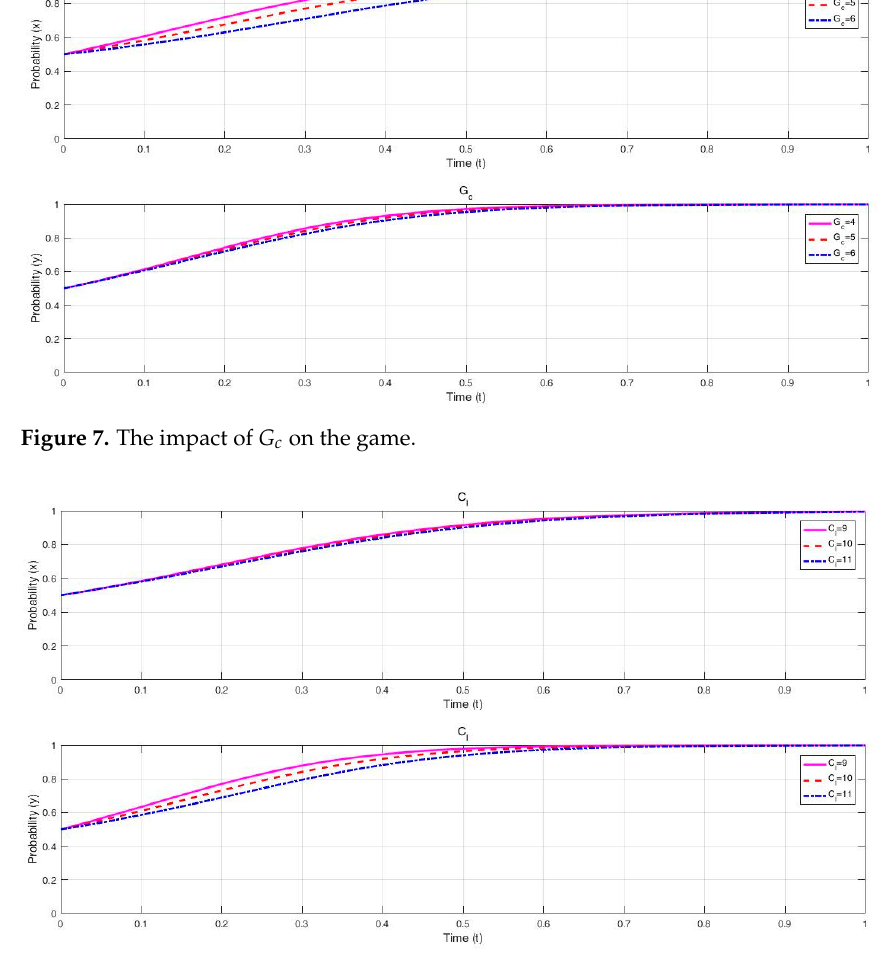
Figure 8. The impact of C l on the game.